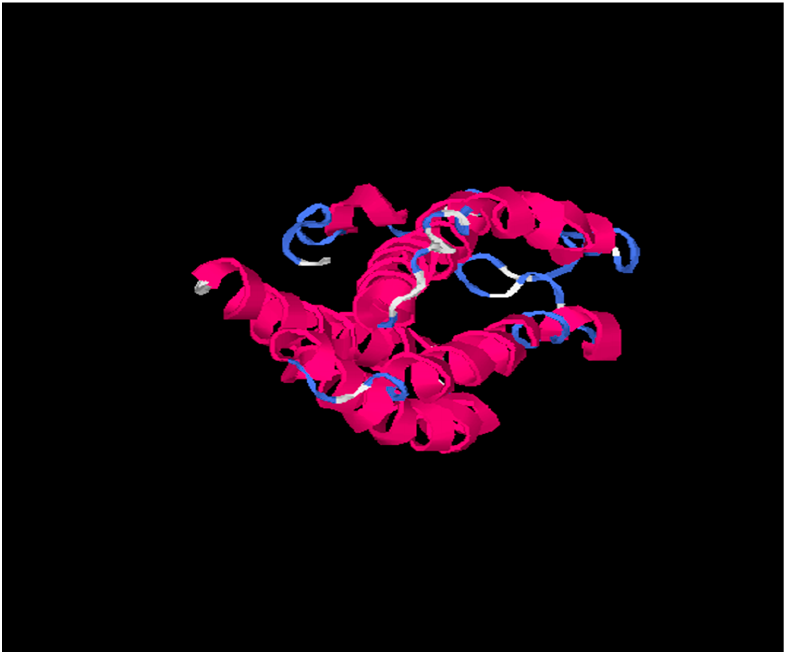
Figure 3. 703029 (HBV Consensus) tertiary structure using I-Tasser online software. Pink is alpha- helix; Blue is coil and white region is extended strand.